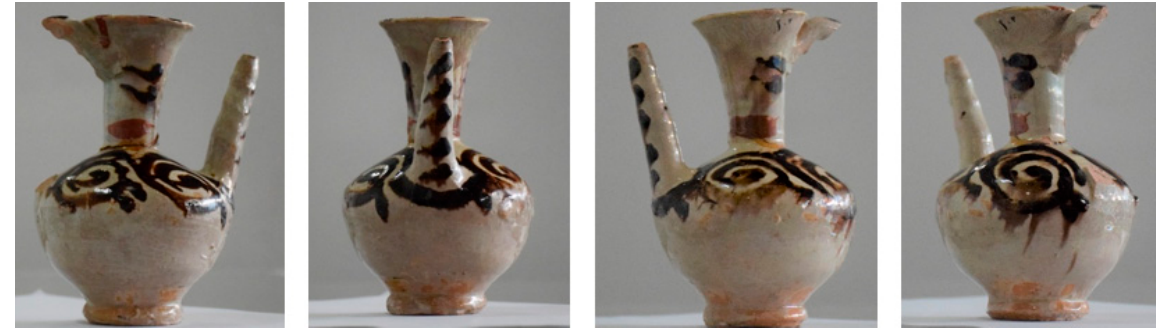
side one and two.